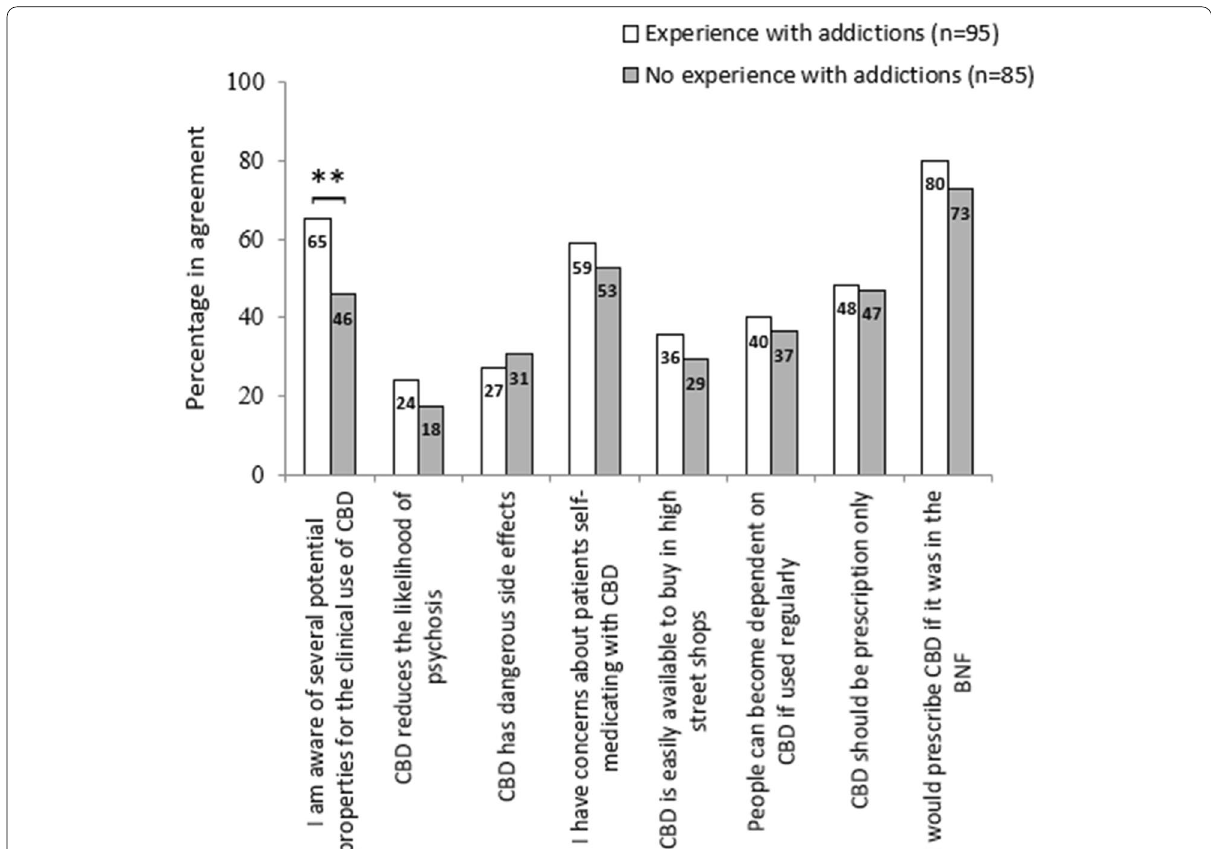
Fig. 2 Staff attitudes toward the medical use of cannabidiol, by addiction experience (percentage responding either ‘agree’ or ’strongly agree’). Data labels represent percentages; differences are on chi-square testing; ** p <